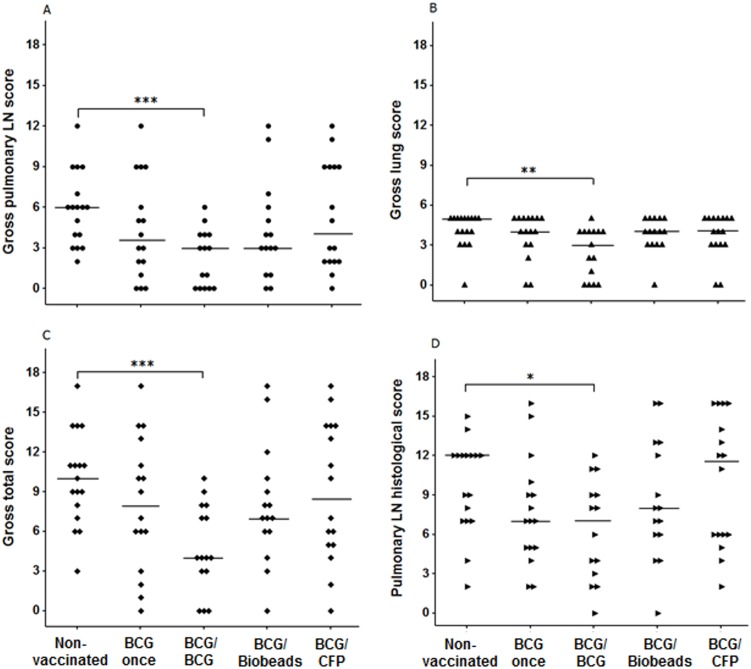
Gross and histopathological lesion scores of cattle following Mycobacterium bovis challenge.Gross pulmonary lymph node (LN) lesion score (A), lung lesion score (B), total lesion score (pulmonary lymph node and lung scores combined) (C) and pulmonary lymph node histopathological lesion score (D). Scores were determined as described in the Material and Methods and scores for individual animals were plotted. Non-vaccinated; BCG once, BCG-vaccinated, not revaccinated; BCG/BCG, BCG-vaccinated and revaccinated 2 years later with BCG; BCG/Biobeads, BCG-vaccinated and revaccinated 2 years later with TB biobeads displaying mycobacterial proteins, ESAT-6 and Ag85A; BCG/CFP, BCG-vaccinated and revaccinated 2 years later with M. bovis culture filtrate protein vaccine. Median indicated by horizontal line. Significant difference from the non-vaccinated group was denoted by ***p<0.001, **p<0.01 and *p<0.05.